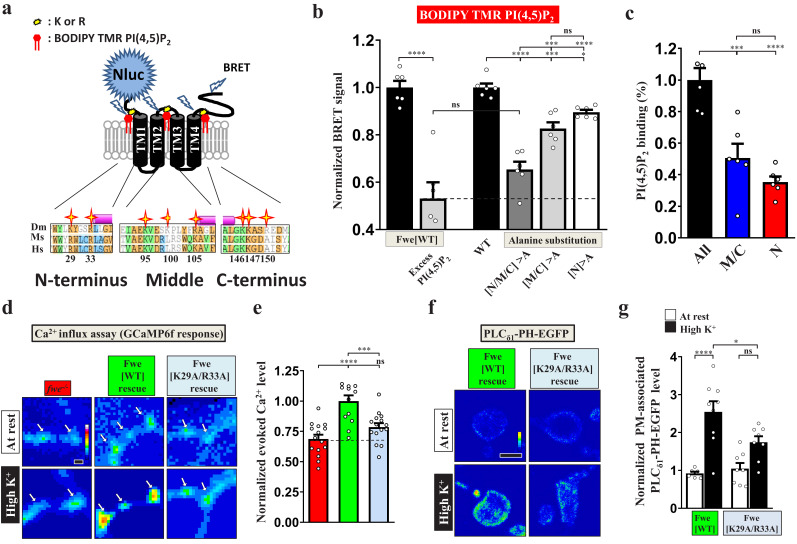
PI(4,5)P2 binds to Fwe and promotes its Ca2+ channelling activity.(a–c) PI(4,5)P2 binds Fwe. (a) A schematic of the Fwe structure and a BRET assay. Stars highlight conserved lysine (K) and arginine (R) in juxta-transmembrane regions: N-terminus (N), middle-domain (M), and C-terminus (C). Drosophila melanogaster (Dm). Mus Musculus (Ms). Human Sapiens (Hs). N-terminal fusion of Nluc to Fwe allows detection of PI(4,5)P2 binding. A 1D4 epitope was used for protein purification. (b) Nluc-Fwe-1D4 in micelles excites BODIPY-TMR-conjugated PI(4,5)P2 to emit BRET signal, which is decreased by competitive cold PI(4,5)P2 (1 mM). Alanine substitution of positively-charged residues in all regions (N/M/C > A), both middle-domain and C-terminus (M/C > A), or N-terminus (N > A) reduced BRET signals. (c) Corresponding PI(4,5)P2 binding ability was calculated by subtracting the signal values of N/M/C > A, M/C > A or N > A from that for WT. Quantification data was normalized to the signal value of all mutations (N/M/C). (d) PI(4,5)P2 controls Fwe channel activity. Snapshot Ca2+ images of the boutons (arrows) expressing lexAop2-GCaMP6f using vglut-lexA. fwe mutant (fweDB25/DB56). HA-Fwe[WT]-APEX2 rescue (nSyb-GAL4/UAS-HA-Fwe[WT]-APEX2 in fweDB25/DB56). HA-Fwe[K29A/R33A]-APEX2 rescue (nSyb-GAL4/UAS-HA-Fwe[K29A/R33A]-APEX2 in fweDB25/DB56). The larvae were reared at 25°C. Images were taken in the fifth minute for one minute after high K+ stimulation. (e) Quantification data for evoked Ca2+ level, normalized to the value of HA-Fwe-APEX2 rescue larvae. (f) Single-plane confocal images of the boutons expressing UAS-PLCδ1-PH-EGFP. The larvae were reared at 25°C. After resting conditions or high K+ stimulation, the boutons were stained with α-GFP. (g) Quantification data for the PLCδ1-PH-EGFP staining intensity, normalized to the value of the resting condition of HA-Fwe-APEX2 rescue larvae. Individual data values are shown in graphs. p values: ns, not significant; *p<0.05; ***p<0.001; ****p<0.0001. Mean ± SEM. Scale bar: 2 µm (d, f). Statistics: Student t-test (b). One-way ANOVA with Tukey’s post hoc test (b, c, e, g).
Figure 4—source data 1.Source data for Figure 4.